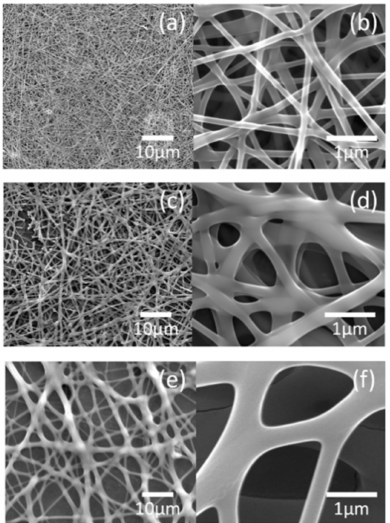
Figure 3. Field-emission scanning electron microscope (FE-SEM) images of as-spun nanofibers obtained from precursor solution 15-A ( a ) low magnification, ( b ) high magnification, as-spun nanofibers obtained from precursor solution 15-B ( c ) low magnification, ( d ) high magnification, and as-spun nanofibers obtained from precursor solution 15-C ( e ) low magnification, ( f ) high